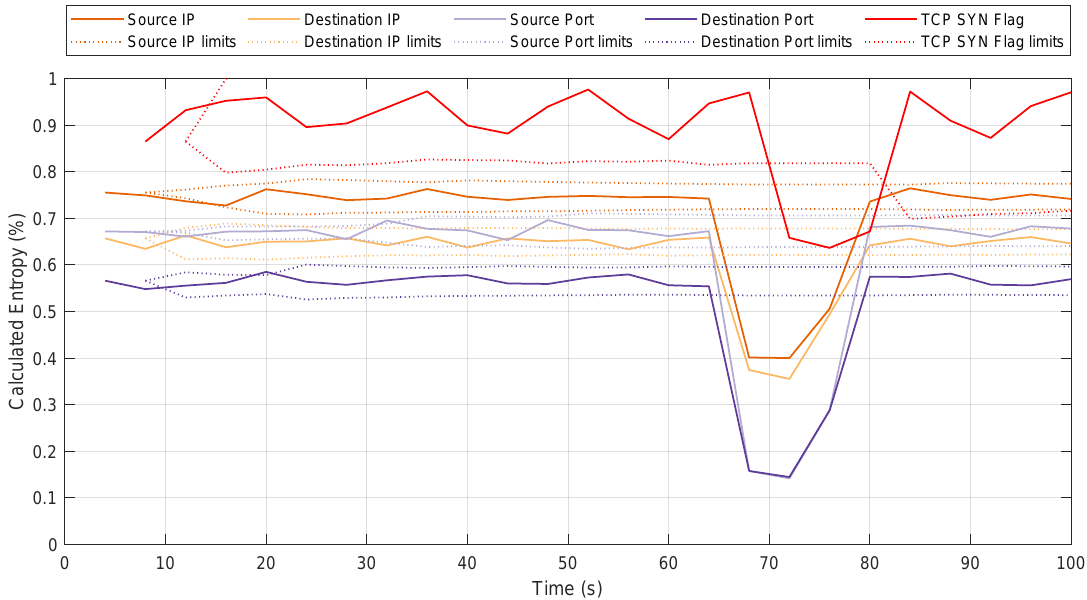
Figure 8. Entropy variation for a Distributed Denial of Service (DDoS) TCP SYN flood